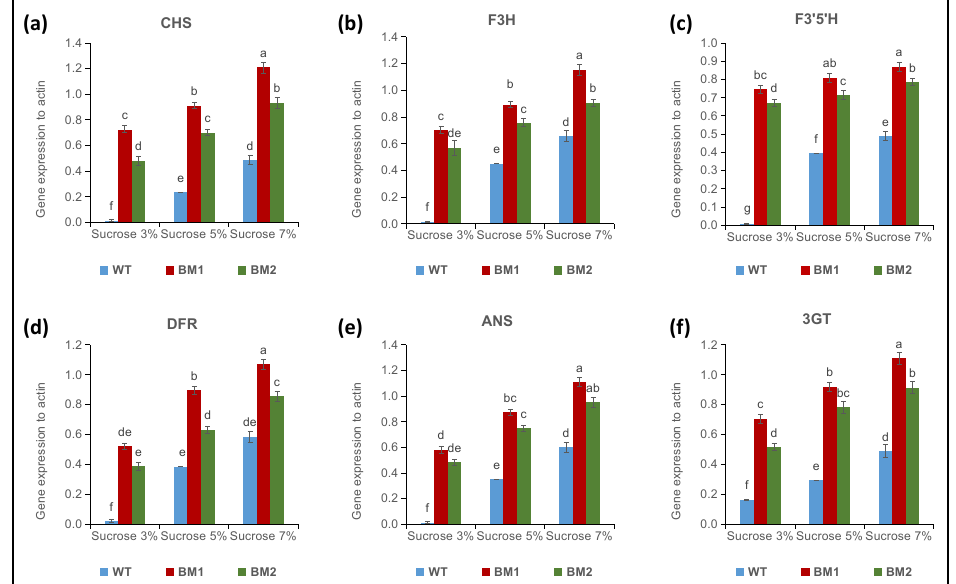
Figure 3. Effect of sucrose on anthocyanin biosynthesis gene expression levels ( a – f ) in WT plants and transgenic lines overexpressing mPAP1 + B-Peru . Data are presented as the means of three replicates. Error bars indicate standard error. Groups annotated with the same letter are not significantly different by Duncan Multiple Range Test (DMRT, p < 0.05). Plant growth parameters, including plant height, root length, and fresh weight, were measured at different sucrose concentrations. WT plants cultured in media containing 3% sucrose had greater growth (plant height, root length, and fresh weight) compared to